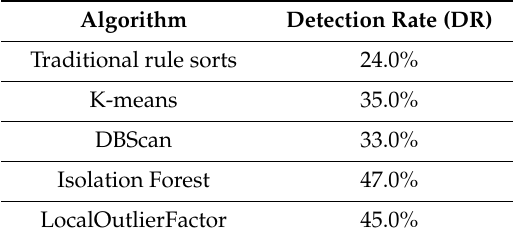
Table 4. Detection rate of di ff erent